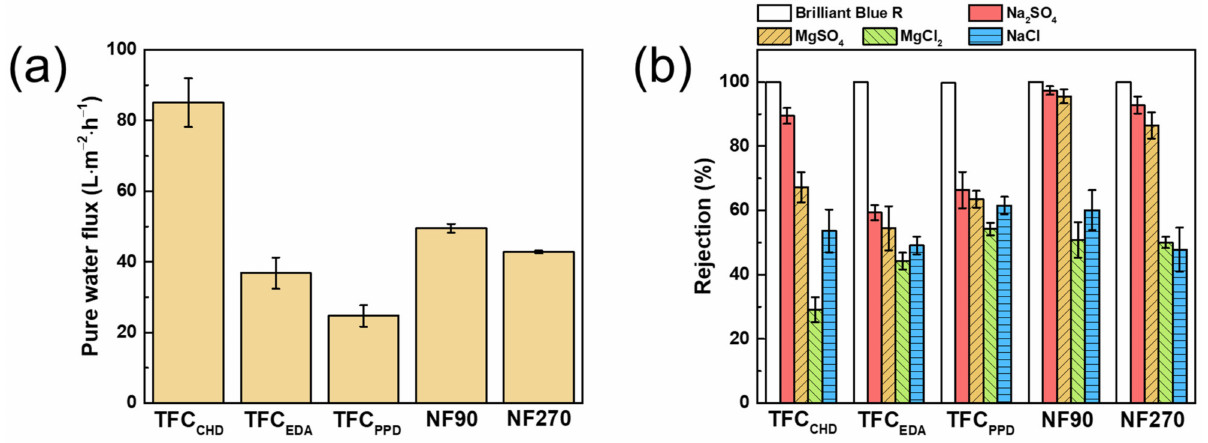
Figure 5. ( a ) pure water flux and ( b ) salt and dye rejection of the TFC and commercial